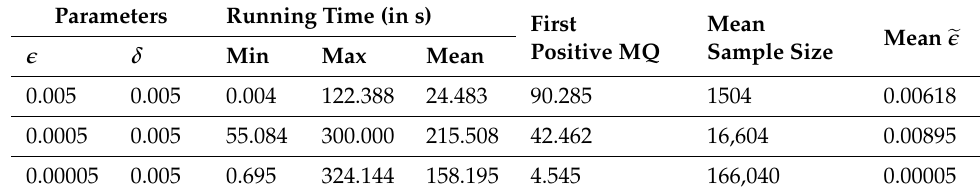
Table 4. Dyck 2: On-the-fly verification of